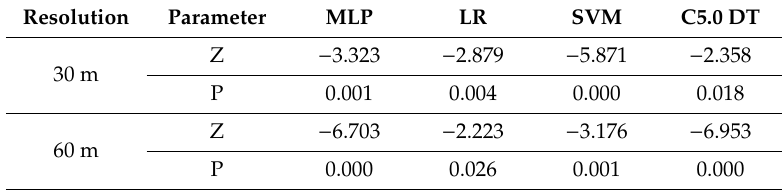
Table 5. Comparison of the results before and after adding SE in models with resolutions of 30 m (60